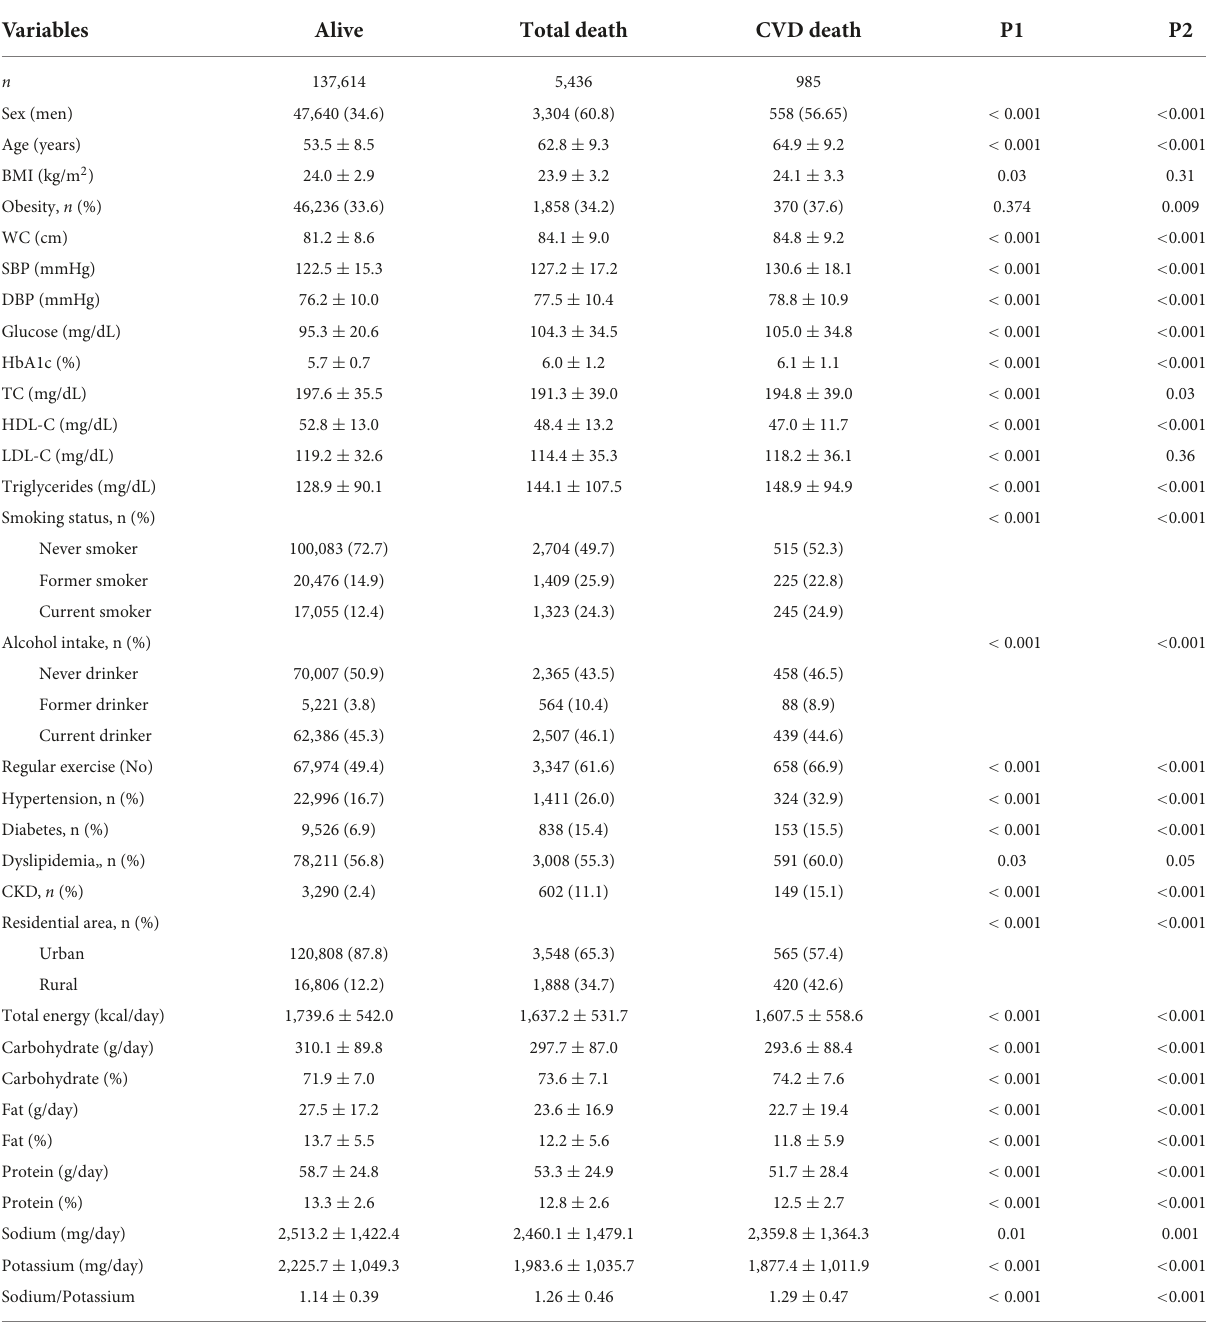
TABLE 1 Baseline characteristics of study population based on mortality